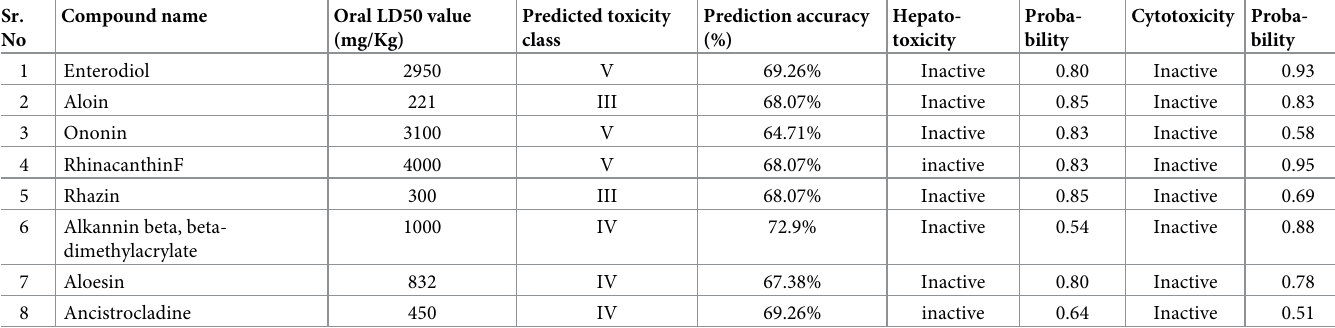
Table 7. Prediction of class and accuracy, organ toxicity, oral acute toxicity and genetic toxicity endpoints of candidate compounds. Sr.